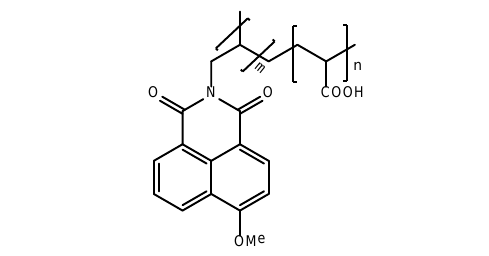
Figure 1. 1,8-Naphthalimide-tagged polyacrylate molecular structure.